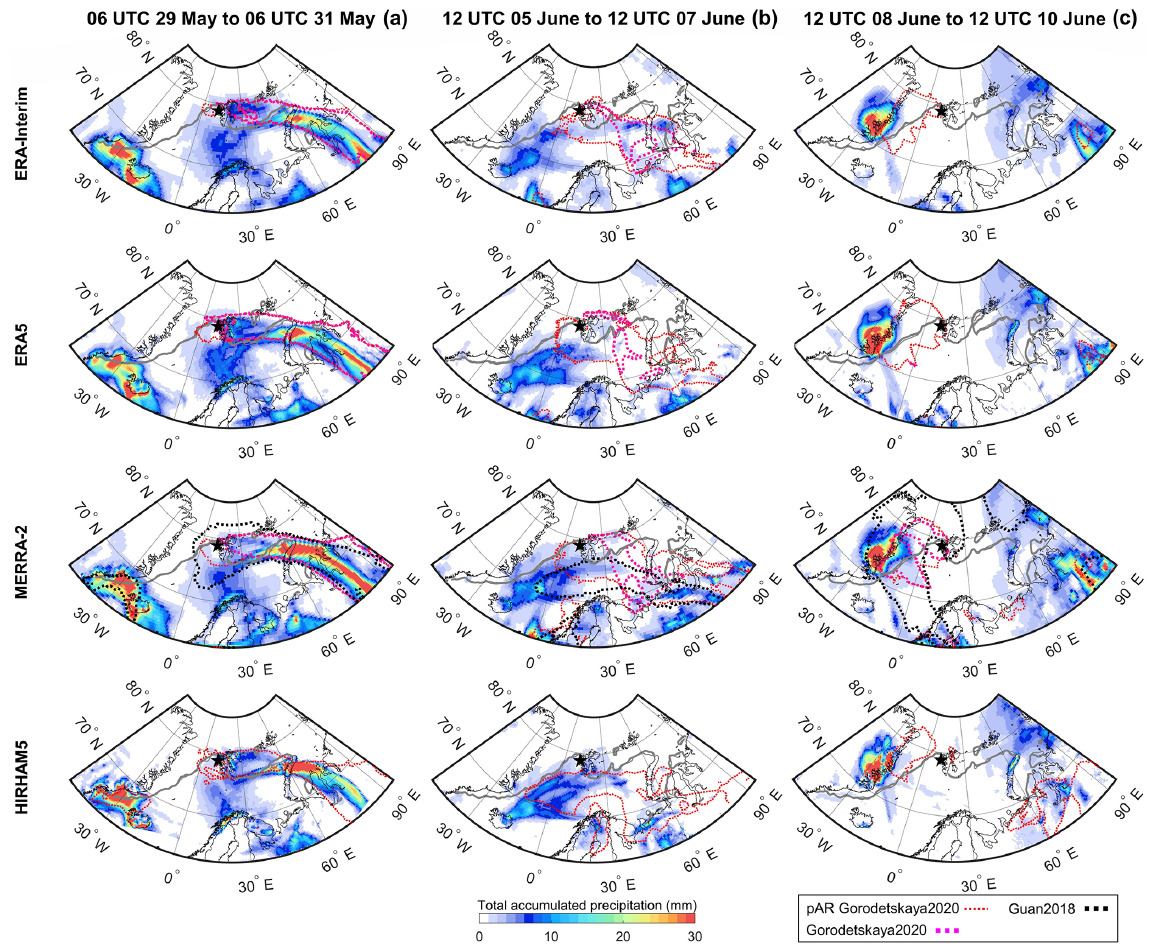
Figure 8. Maps of the total accumulated precipitation (mm, coloured shading) for the 30 May event (first column, a ), the 6 June event (second column, b ), and the 9 June event (third column, c ) during a 48h period (24h before and after the AR reaches Ny-Ålesund, shown by the black star) based on reanalyses (ERA-Interim, ERA5, and MERRA-2) and the HIRHAM5 model. The grey lines show the sea-ice fraction using a 15% threshold (the thin line represents 24h before the event, and the thick line represents 24h after the event). The magenta and red lines show the respective AR and pAR shapes based on Gorodetskaya2020. The black line shows the AR shape based on Guan2018 (available only for MERRA-2). Here, the AR shape lines encompass the total area of the ARs/pARs during the 48h period. Figures S11, S12, and S13 show the discrimination of the precipitation phase (snowfall and rainfall) for all datasets.